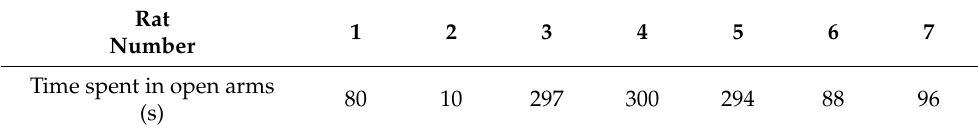
Table 3. The time spent in open arms by each individual rat from the ketamine + isolation + aripiprazole